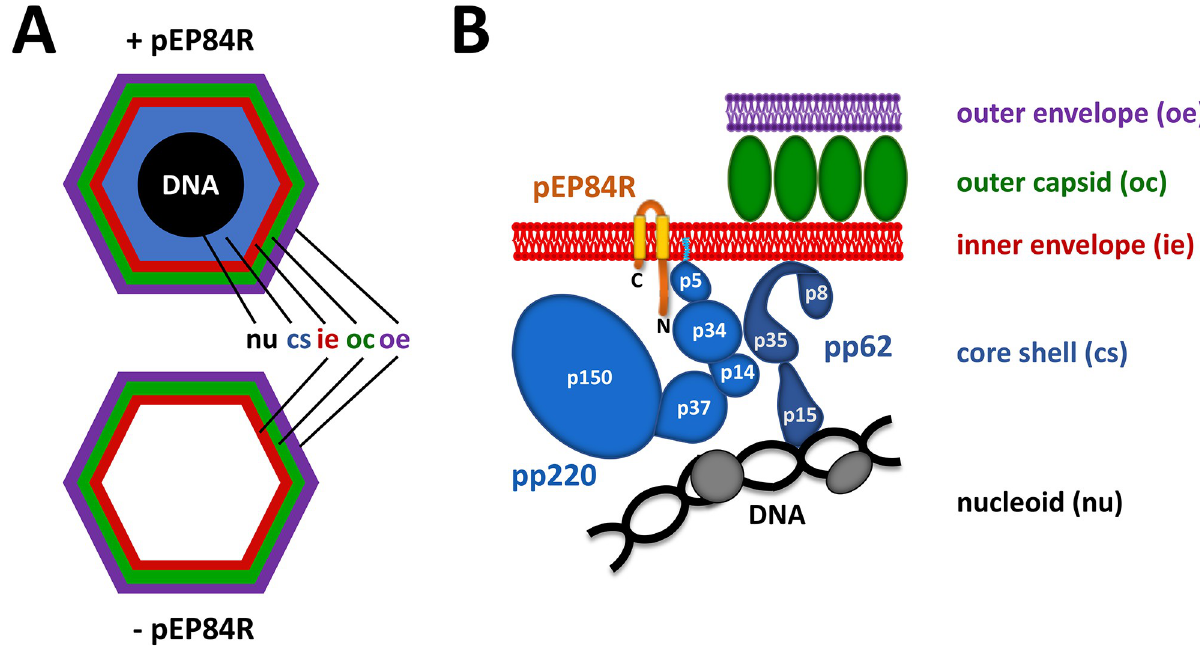
Fig 8. Role of pEP84R in ASFV core assembly. (A) Schematic depiction of the structure of ASFV particles generated in the presence (+) or absence (-) of pEP84R. The different virus layers are indicated. (B) Model for ASFV core assembly. Transmembrane protein pEP84R guides the assembly of the viral core beneath the inner envelope by interacting with polyprotein pp220, a binding that probably involves the N-terminal regions of both polypeptides. Precursor pp220, in turn, interacts with polyprotein pp62 to form the core shell, whose membrane anchoring would be further sustained by N-myristoylation of pp220 and a positively charged aa patch present in the p35 region of pp62. The interaction of the core shell with the underlying nucleoid likely involves the DNA binding domain of the pp62-derived product p15 together with other DNA-protein and protein-protein interactions not described so far. In the model, the names of the final processing products derived from pp220 (p5, p34, p14, p37 and p150) and pp62 (p15, p35 and p8) are indicated but not intended to represent actual structures or positions in the mature virion.